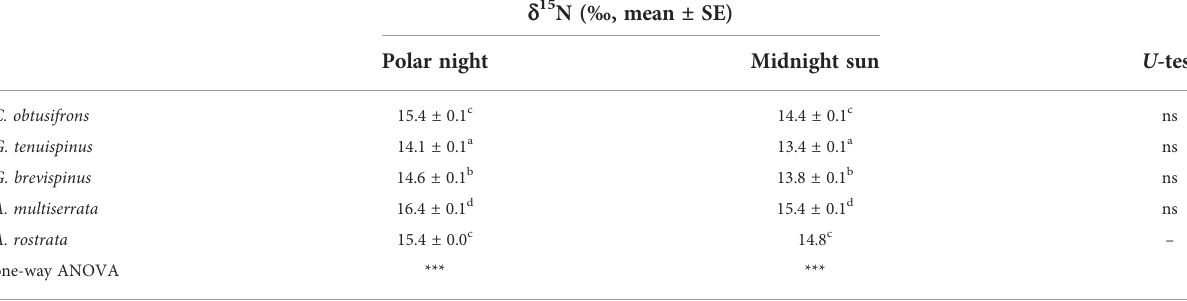
TABLE 4 Summary of d 15 N value ( ‰ , mean ± SE) of fi ve Aetideidae copepods in the western Arctic Ocean during the polar night and midnight